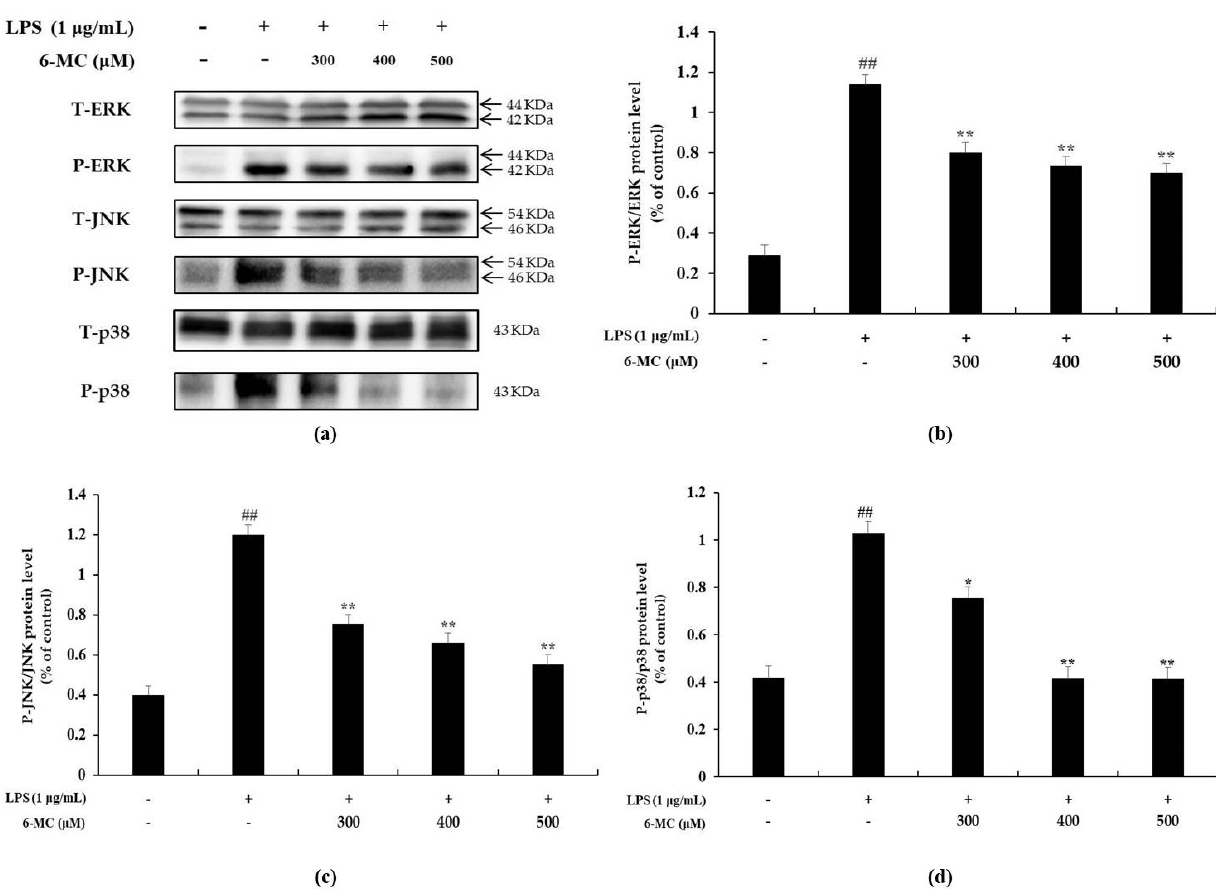
Figure 6. Effect of 6-MC on phosphorylation level of MAPK in LPS-induced RAW 264.7 cells. ( a ) Result of Western blotting, and protein levels of ( b ) P-ERK/ERK, ( c ) P-JNK/JNK, and ( d ) P-p38/p38. Lysates were prepared from cells pretreated with 6-MC (300, 400, and 500 μM) for 1 h and then treated with LPS (1 μg/mL) for 15 min. β-actin was used as a loading control. Total cellular proteins were separated using SDS-PAGE, transferred to PVDF membranes, and detected using specific antibodies against phospho-ERK, T-ERK, phospho-JNK, T-JNK, phospho-p38, and T-p38. P: phosphorylated, T: total. The results in the graphs are presented as the mean ± SD from three independent measurements using the ImageJ program. ## p < 0.01 vs. untreated control group. * p < 0.05, ** p < 0.01 versus group treated with LPS alone.